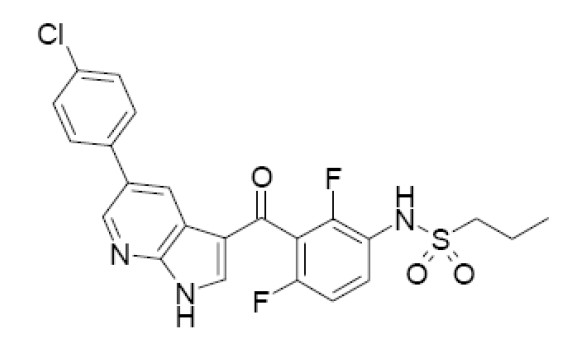
The structural formula of vemurafenib.